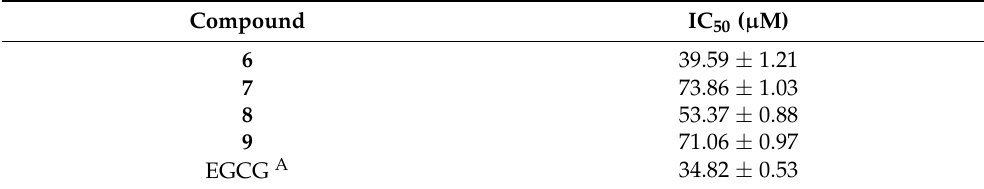
Table 5. Anti-collagenase activity of compounds 6 – 9 and their respective IC 50